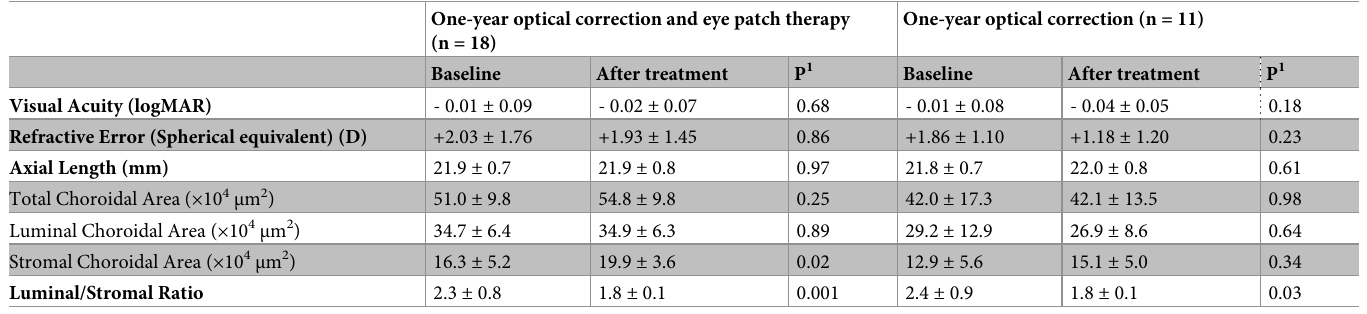
( P = 0.02; paired t test, Table 4). Thus, the luminal/stromal ratio of the fellow eye was sig- nificantly decreased after wearing the optical correction ( P = 0.001; paired t test, Table 4). There was no differential trend in the choroidal structures between children who received only optical correction and those who received both optical correction and patching. The ocular examinations of the control children were done at the baseline and after one year without optical treatments. In these eyes, there were no significant changes in the choroi- dal areas after one year (Table 5 and Fig 1). In the univariate analysis of the amblyopic eyes using the structural parameters (total cho- roidal area, luminal, stromal areas, and luminal/stromal ratio) and the axial length, the improvement of the BCVA was significantly correlated with the stromal area at the baseline ( r = 0.64, P = 0.001; Pearson’s correlation coefficient; Fig 2). There was no significant correla- tion between the axial length and total choroidal area at the baseline ( r = -0.01, P = 0.64; Pear- son’s correlation coefficient). When the associated factors ( P < 0.1) from univariable analysis and potential confounders (age, sex) were included in the multiple linear regression models, a better visual acuity improvement was associated with the larger stromal area at the baseline ( β = 0.766; P = 0.001; Table 6). Table 4. Data of the fellow eye of the amblyopic patients before and after one-year